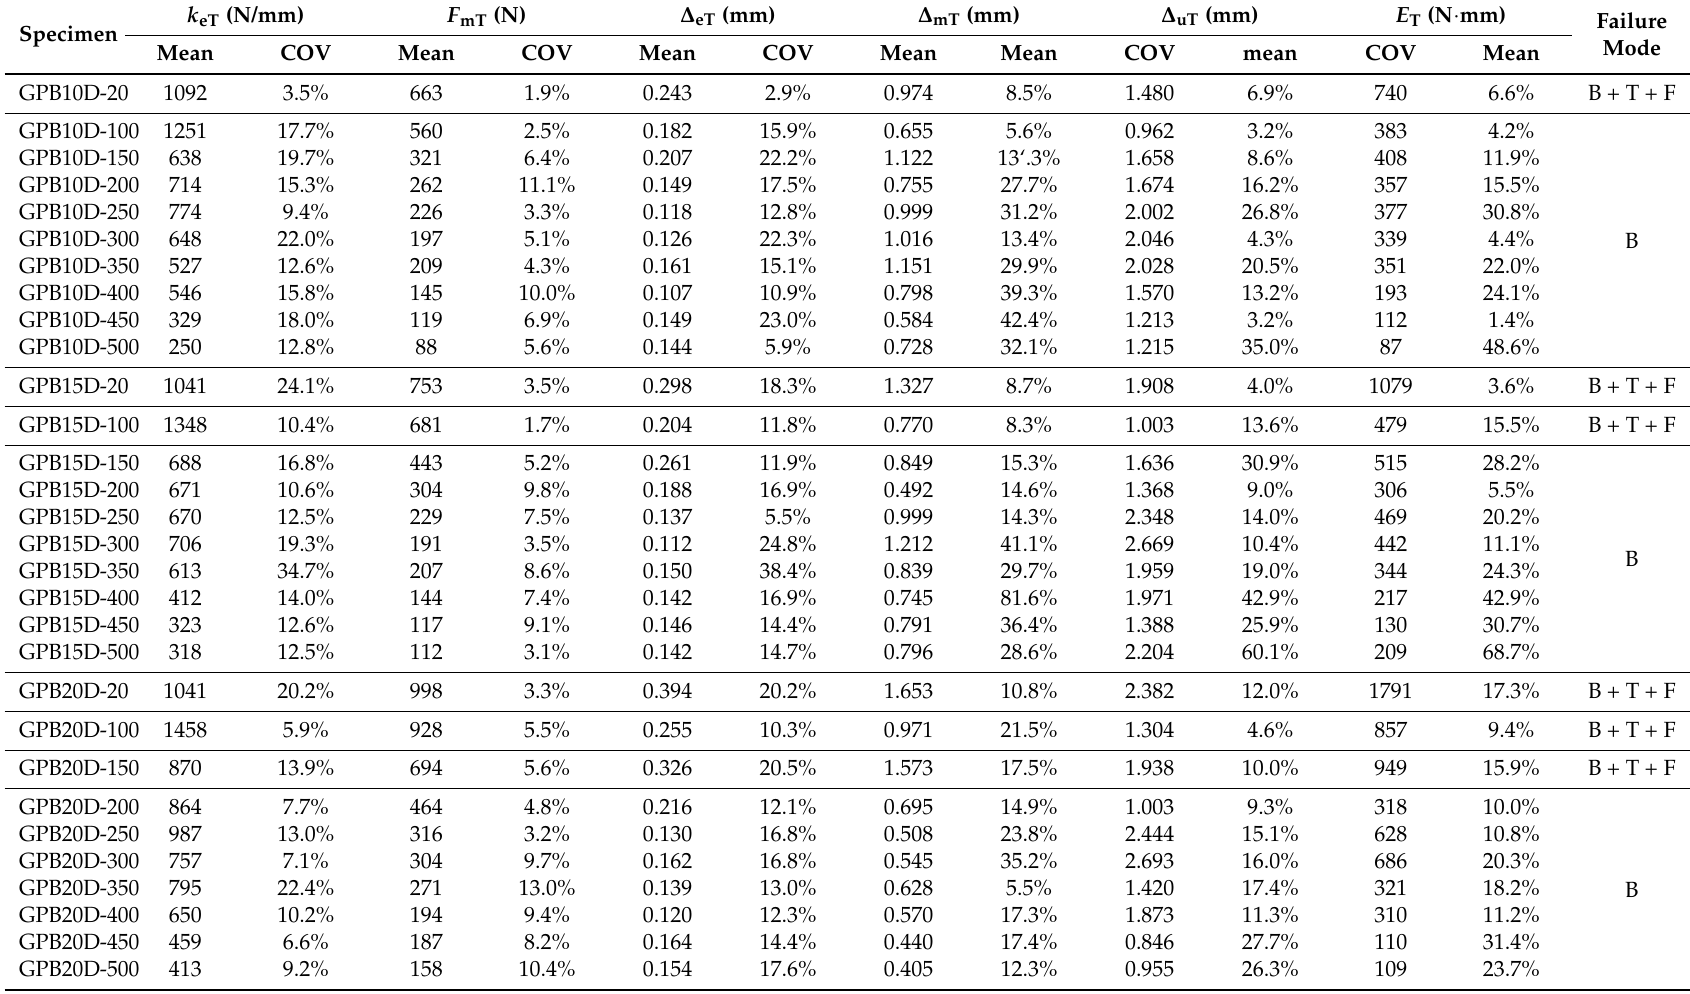
Table 2. Experimental results of CFS screw connection with double-layer gypsum